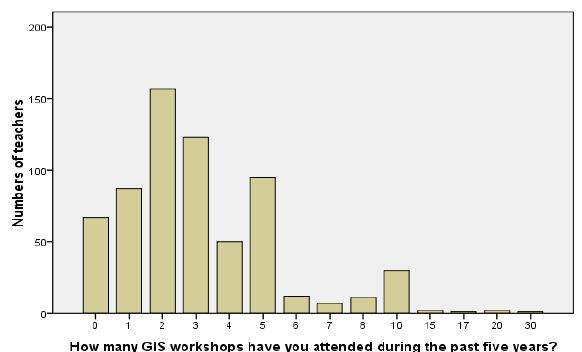
Source: GIS Census in